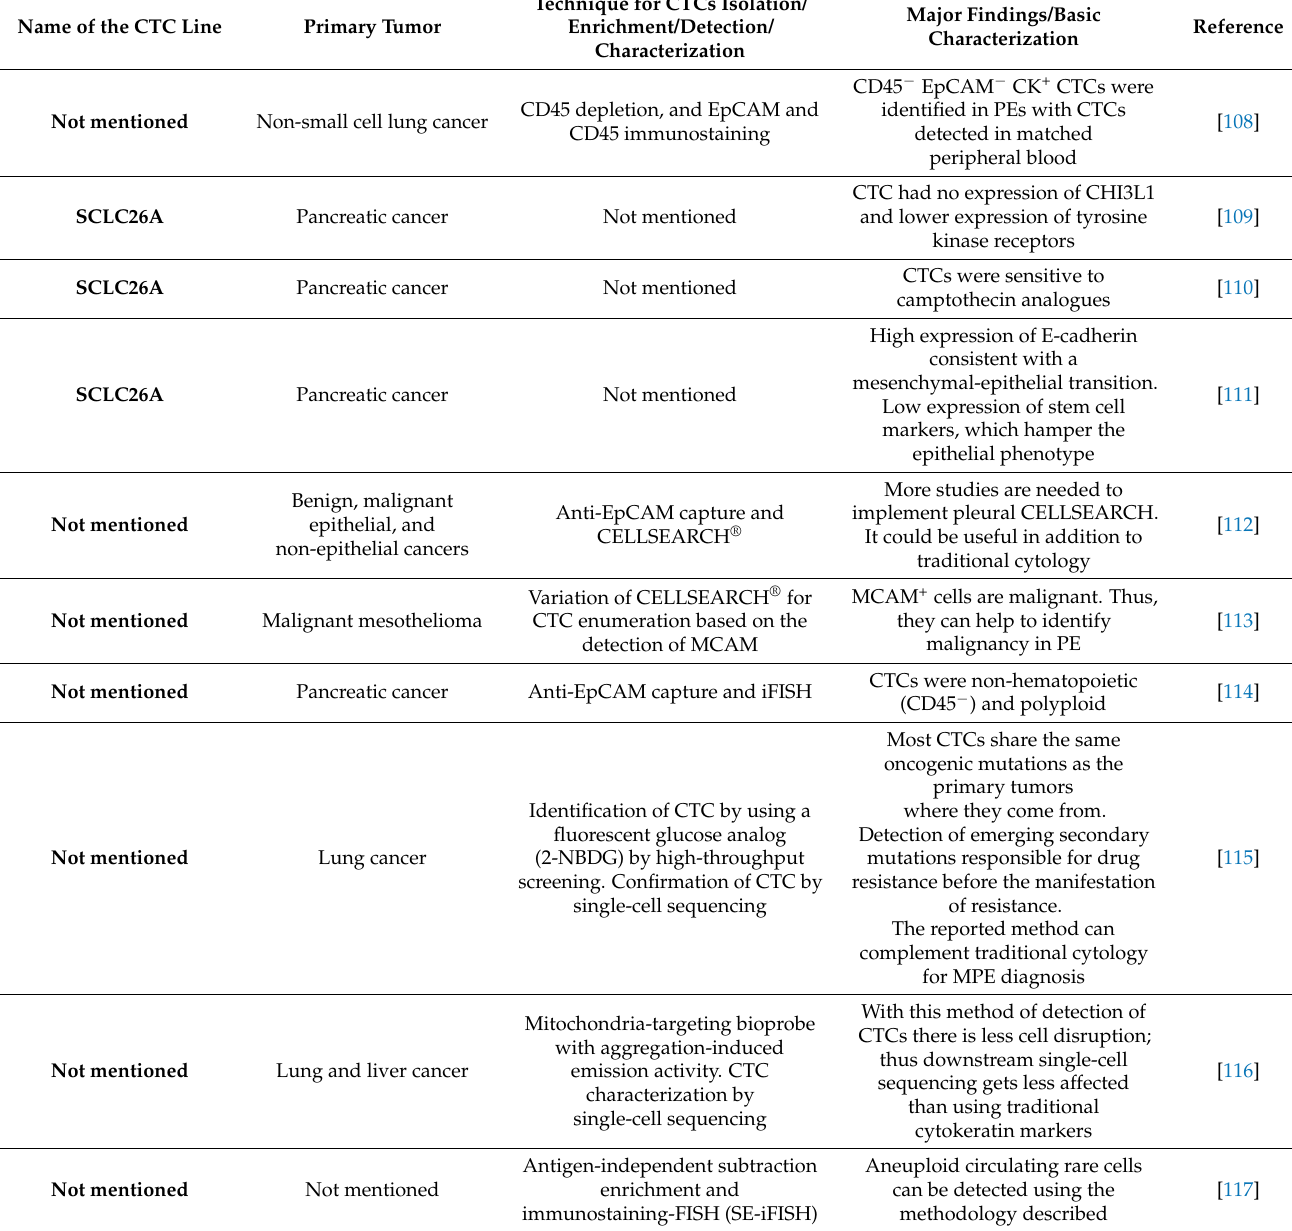
Table 3. Studies exploring the detection and characterization of CTC by different techniques in pleural effusions. Name of the CTC